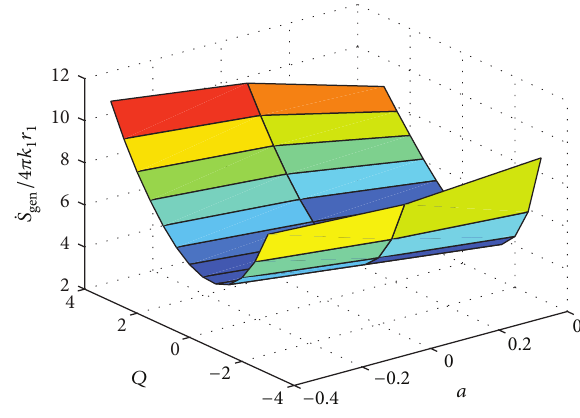
̇𝑆 with respect to “ 𝑎 ” and “ 𝑄 gen